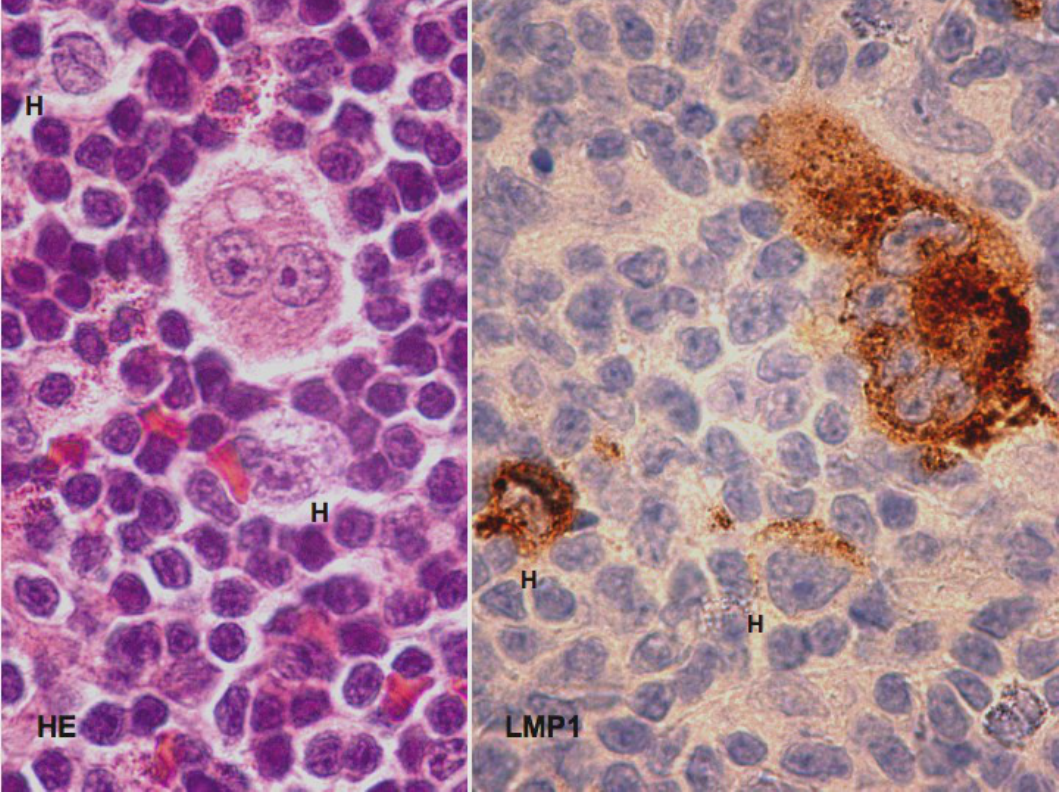
Figure 1. Mononuclear H-cells and bi/multinuclear diagnostic RS-cells. Hematoxilin- Eosin (HE) staining reveals two H-cells and one binuclear RS-cell (left). Immunostaining with anti-LMP1 antibody identifies two H-cells and one multinuclear RS-cell (right). In Western countries about 40% of HL cases express the EBV-encoded oncoprotein